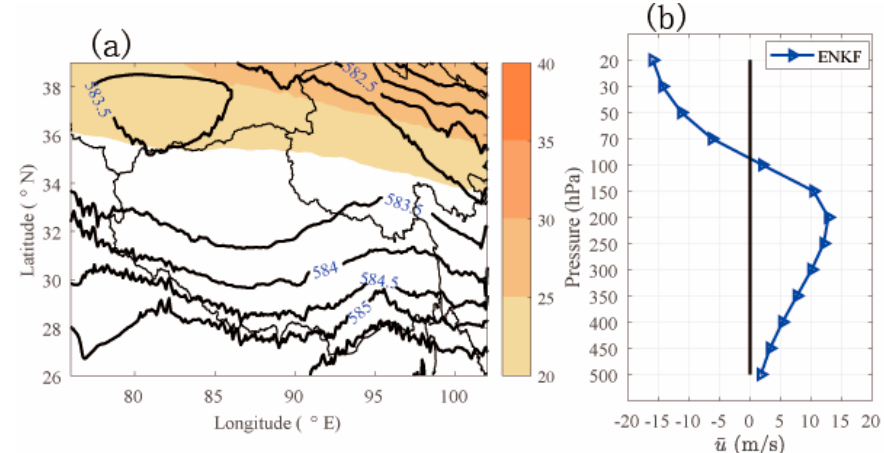
Figure 2. ( a ) Zonal wind speed at 200 hPa (shading: greater than 20 m / s; contour interval is 5 m / s) and geopotential height at 500 hPa (thick black lines). ( b ) Area and 3 − month − averaged zonal wind (blue triangle line) varying with height.